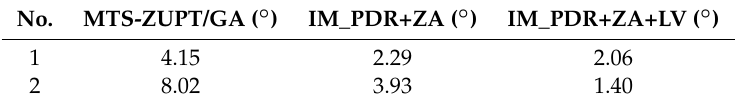
Table 7. Average heading errors of different approaches.